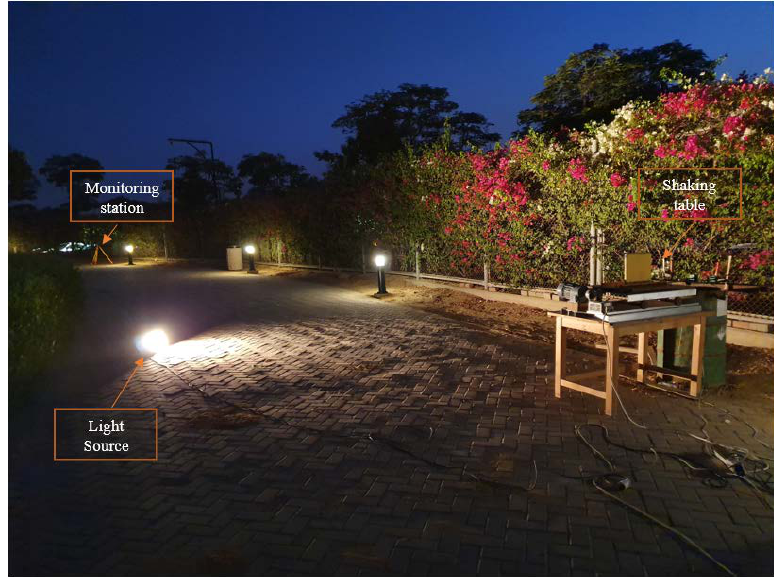
Figure 13. Monitoring shaking table from the second station (28 m apart), at night condition.